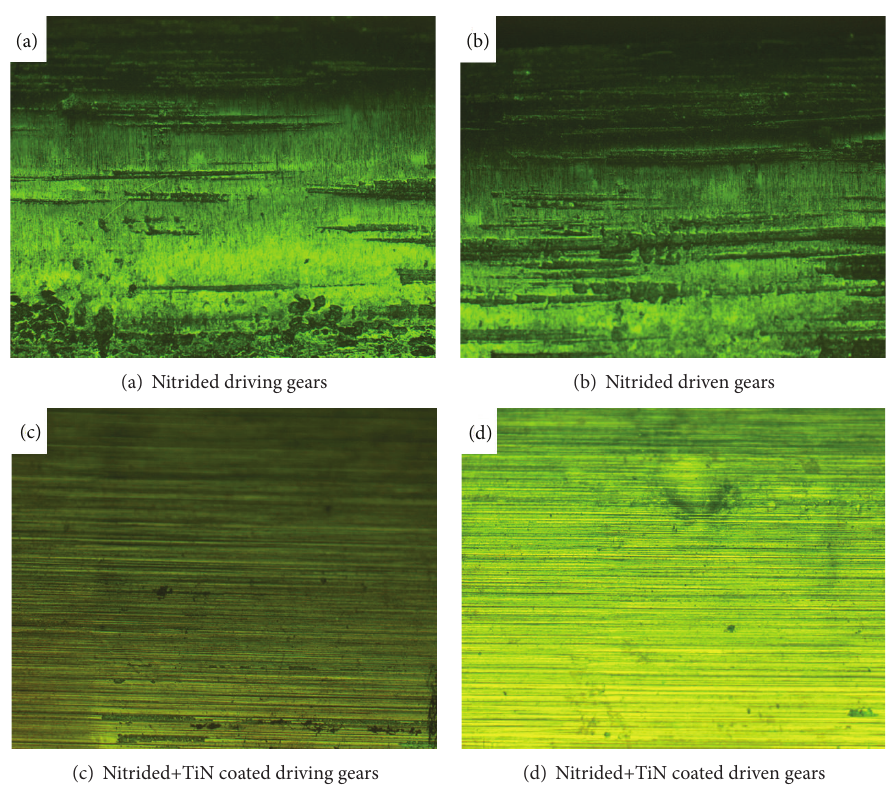
Figure 4: The photograph of tooth surface after running test magnified 50 times.